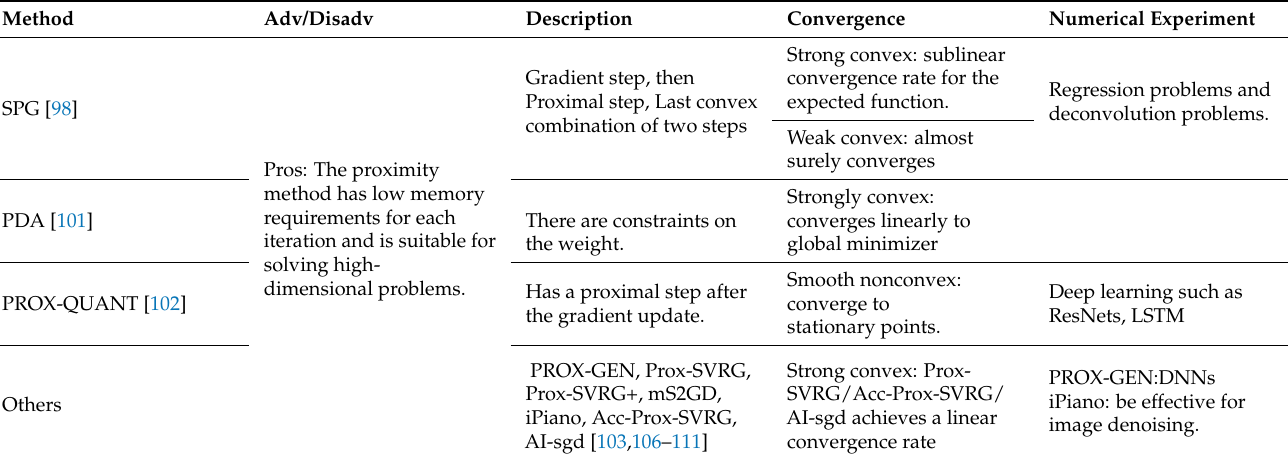
Table 7. Summary of the proximal